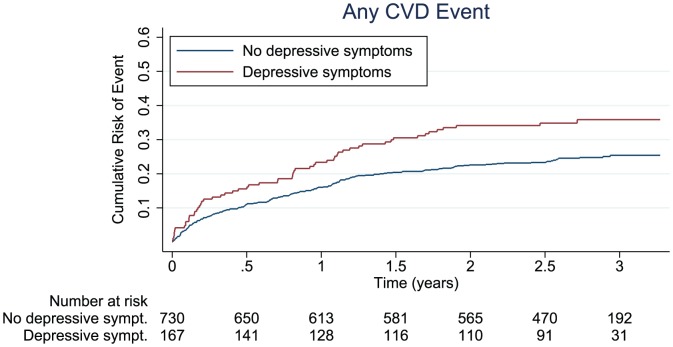
Cumulative Incidence of Any Event, Any Cardiovascular Event, or All-cause Mortality.For MI-patients with and without depressive symptoms, the Cumulative Incidence of Any Event was 47.2% and 30.0% (P<0.001), of Any Cardiovascular Event was 35.9% and 25.4% (P = 0.003) and of Death was 23.0% and 8.0% (P>0.001).